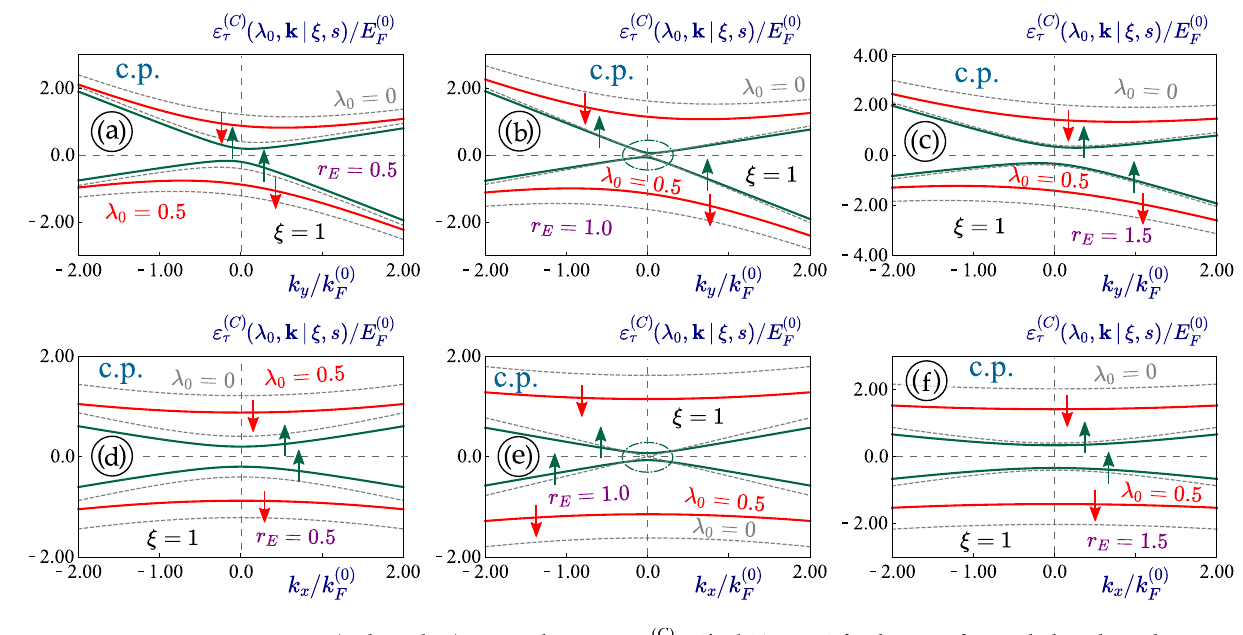
( C ) (cid:31) k 1, s ) for the case of a circularly-polarized ξ Figure 7. (Color online) Energy dispersions ε 0 , 1 ( τ | = 0 ) and the same =± irradiation applied to a 1T ′ -MoS 2 lattice. The dispersions for non-irradiated materials ( (cid:31) 0 = lattice parameters are also shown as dashed and gray curves for comparison. Upward and downward spin states 1 are denoted by green and red arrows, respectively. Panels ( a )-( c ) present the initial 1 and s with s = − = + asymmetric k y -dependence of electron band structure, the lower panels ( d )-( f ), on the other hand, demonstrate their k x -dependence. As labeled, each two panels are related to each other by a selected value for external 1 0.5 [( a ), ( d )], 1.0 [semi-metallic; ( b ), ( e )] and 1.5 [( c ), ( f )]. Here, K -valley with ξ electrostatic field r E = + = was considered for all plots.